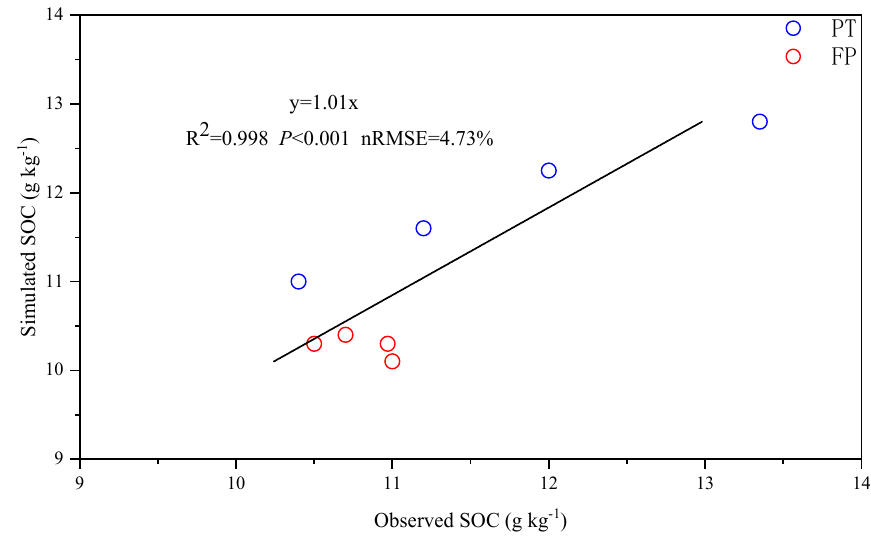
Figure 3. The simulated and observed values of total N 2 O emissions in 2016. FP represents farm- ers’ conventional practice; PT represents optimal practice.